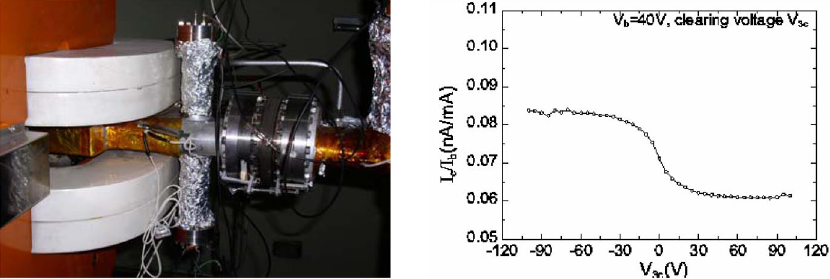
FIG. 7. (Color) The picture of the detectors used as the clearing electrode and the measured I